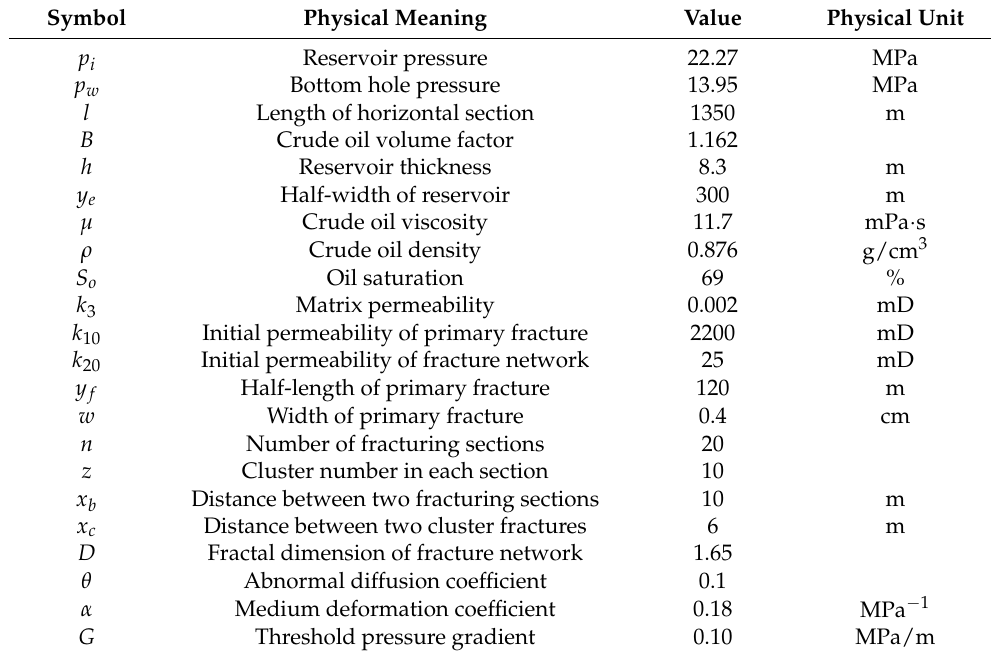
Table 3. Primary parameters of well C1 in block